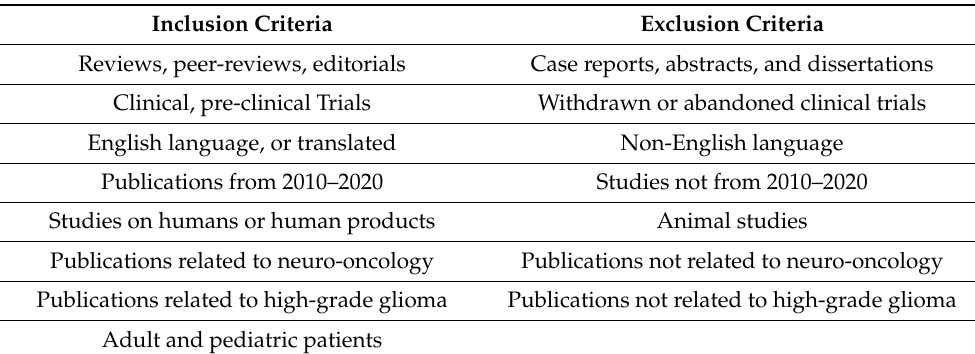
Table 1. Inclusion and exclusion criteria for systematic